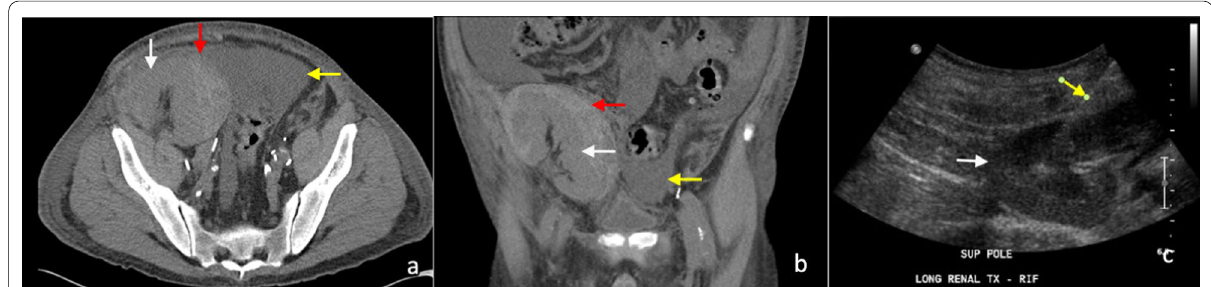
Fig. 10 Unenhanced ( a ) axial and ( b ) coronal, CT images of a subcapsular haematoma (red arrow) following an ultrasound-guided non-targeted 14-gauge core biopsy of a right iliac fossa renal transplant allograft (white arrow). The patient had a moderate volume of ascites (yellow arrow) present prior to the biopsy. c An ultrasound-guided non-targeted core biopsy of the right iliac fossa renal graft (white arrow) was performed with a 14-gauge needle (yellow arrow) for deteriorating renal function. The single-pass 14-gauge core biopsy demonstrated features of acute on chronic graft rejection